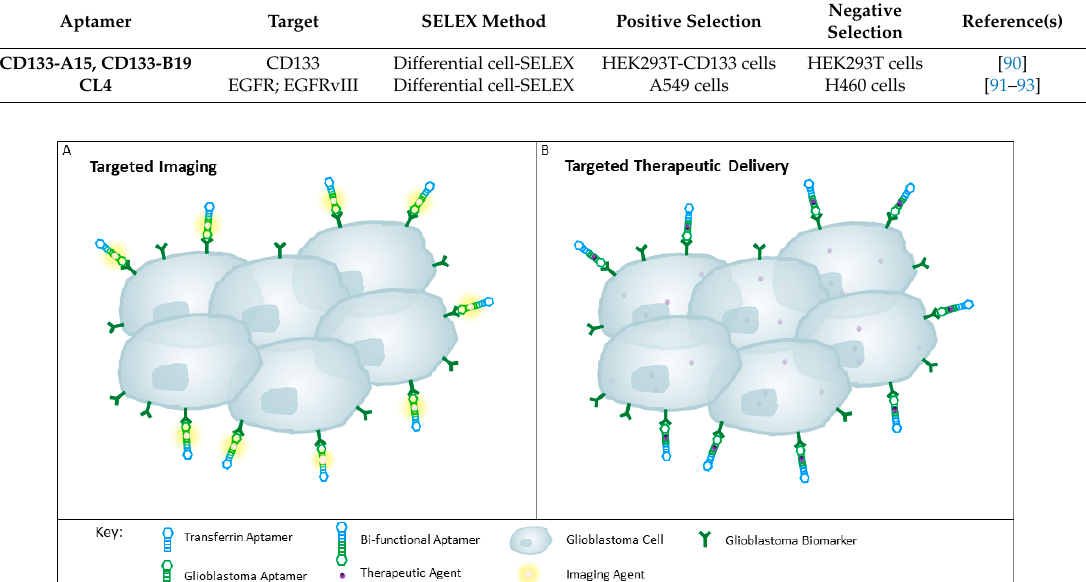
Figure 4. Schematic representation of aptamers for targeting glioblastoma tissue. ( A )